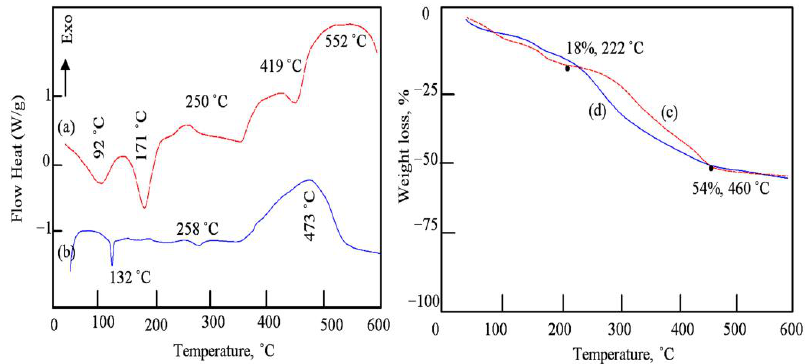
Figure 6. Thermal analyses of ( a ) DSC curve of NHZ-1, ( b ) DSC curve of NHZ-2, ( c ) TG curve of NHZ-1, and ( d ) TG curve of NHZ-2.